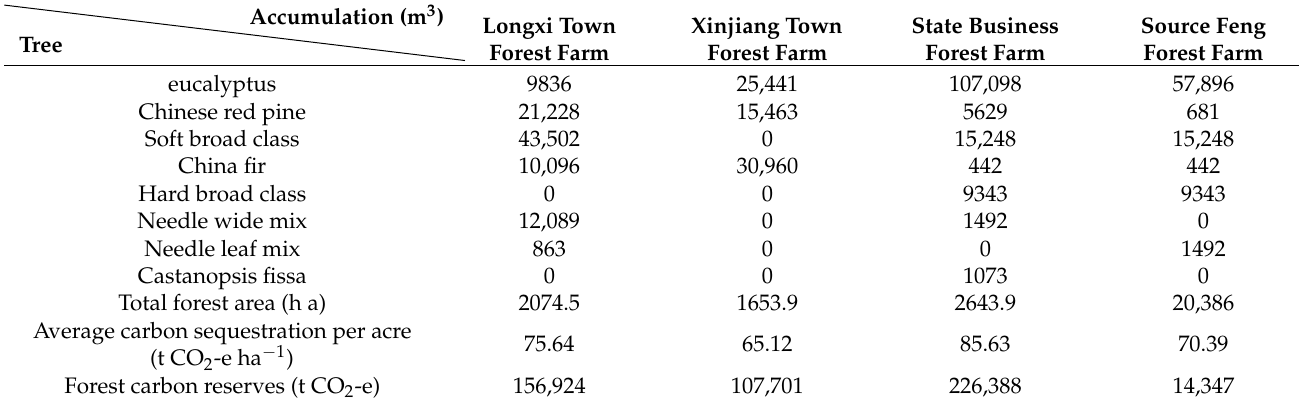
Table 5. Tree species area and carbon reserves of the forest farm.